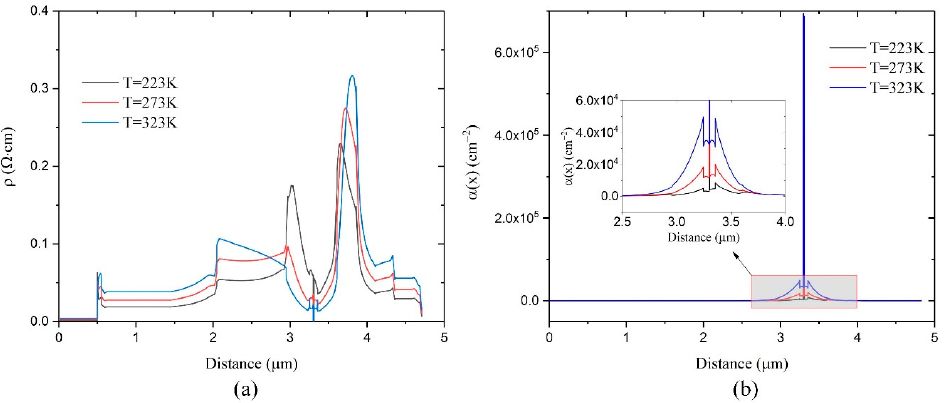
Figure 4. Temperature effects in the epitaxial direction at an injection current of 10 A ( a ) electrical resistivity, ( b ) free carrier absorption intensity.